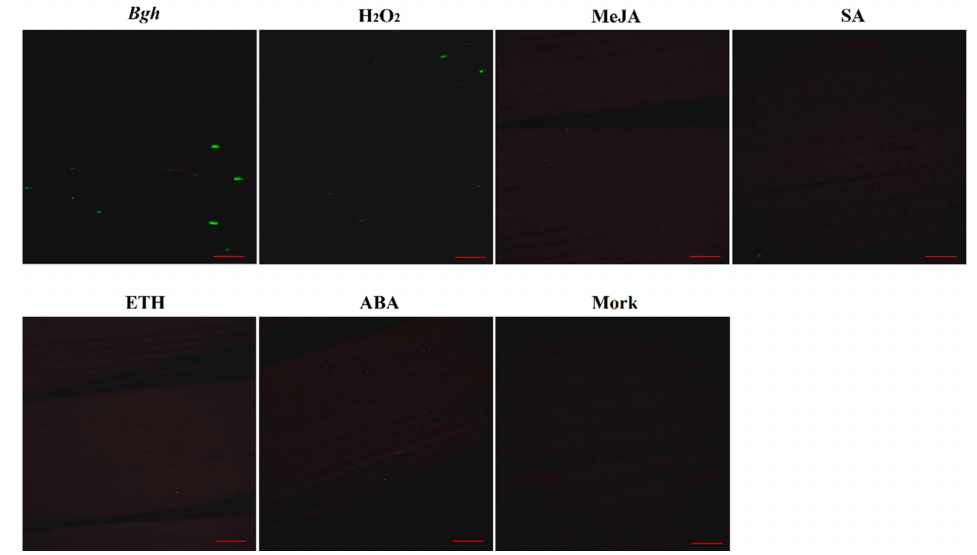
Figure 5. Activity of the HvSERK2 promoter in response to Bgh , H 2 O 2 , MeJA, SA, ETH, and ABA treatments. Mork is control. Bars = 1 mm.